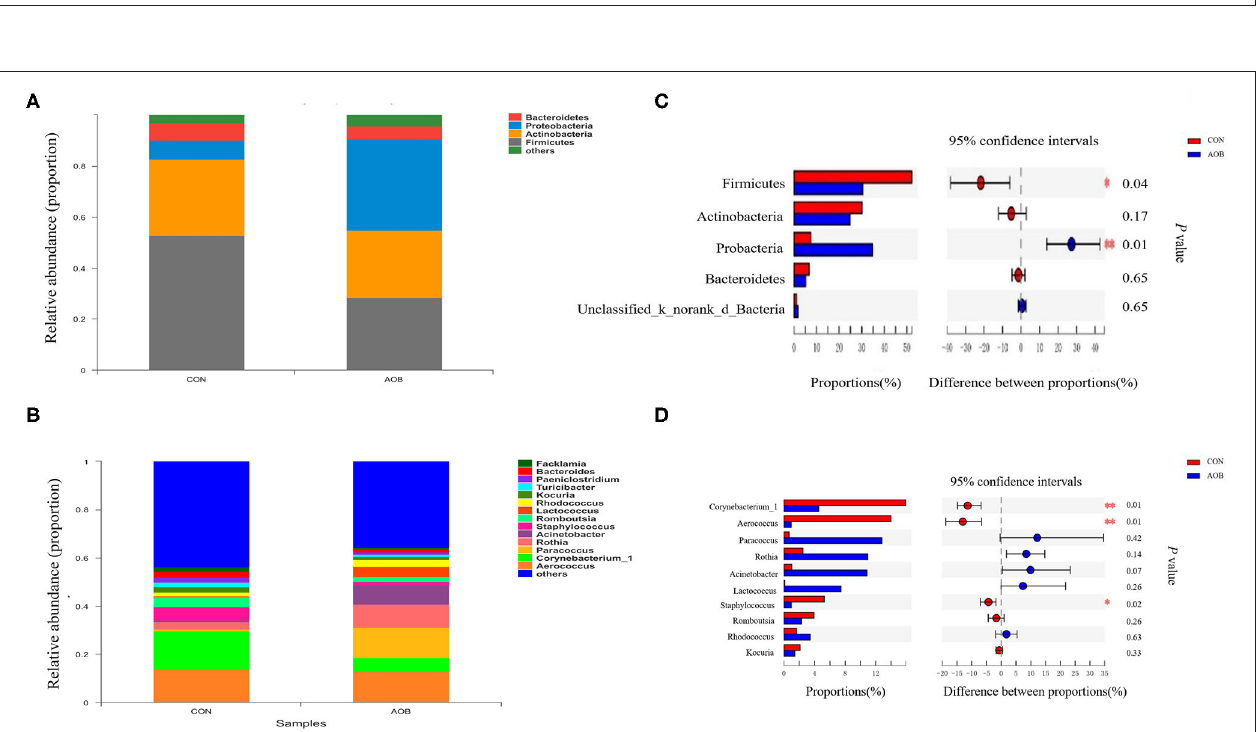
FIGURE 2 | Classification of the bacterial community composition identified in milk samples from lactating cows fed TMR with supplementation of 0 (CON) and 60 g/d of bamboo leaf extracts (AOB), n = 6. (A) Phylum level. (B) Genus level. (C) Differences between the relative abundances of five predominant bacterial phyla in milk samples between two groups. (D) Differences between the relative abundances of the 10 predominant bacterial genera in milk samples between two groups. The extended error bar plot was generated using STAMP software. Welch’s two-sided test was used, and Welch’s inverted test was 0.95. TMR, total mixed ration.